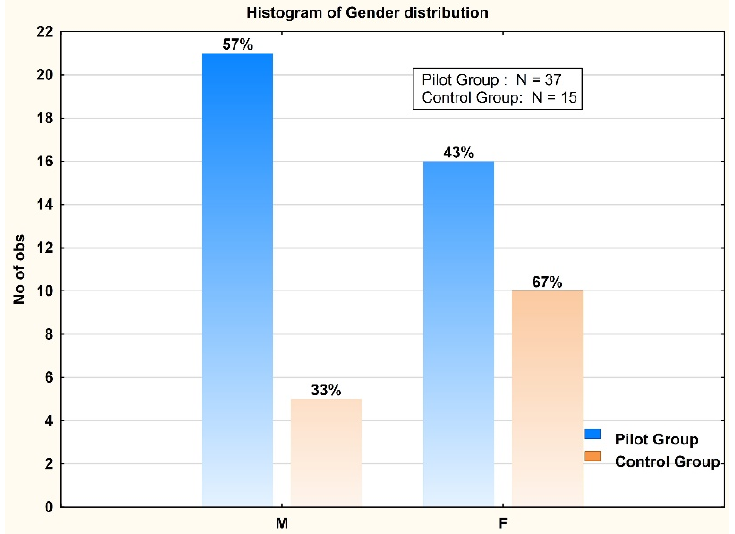
Figure 2. Histogram representation for the gender distribution of the control group (CG) and the pilot group (PG).